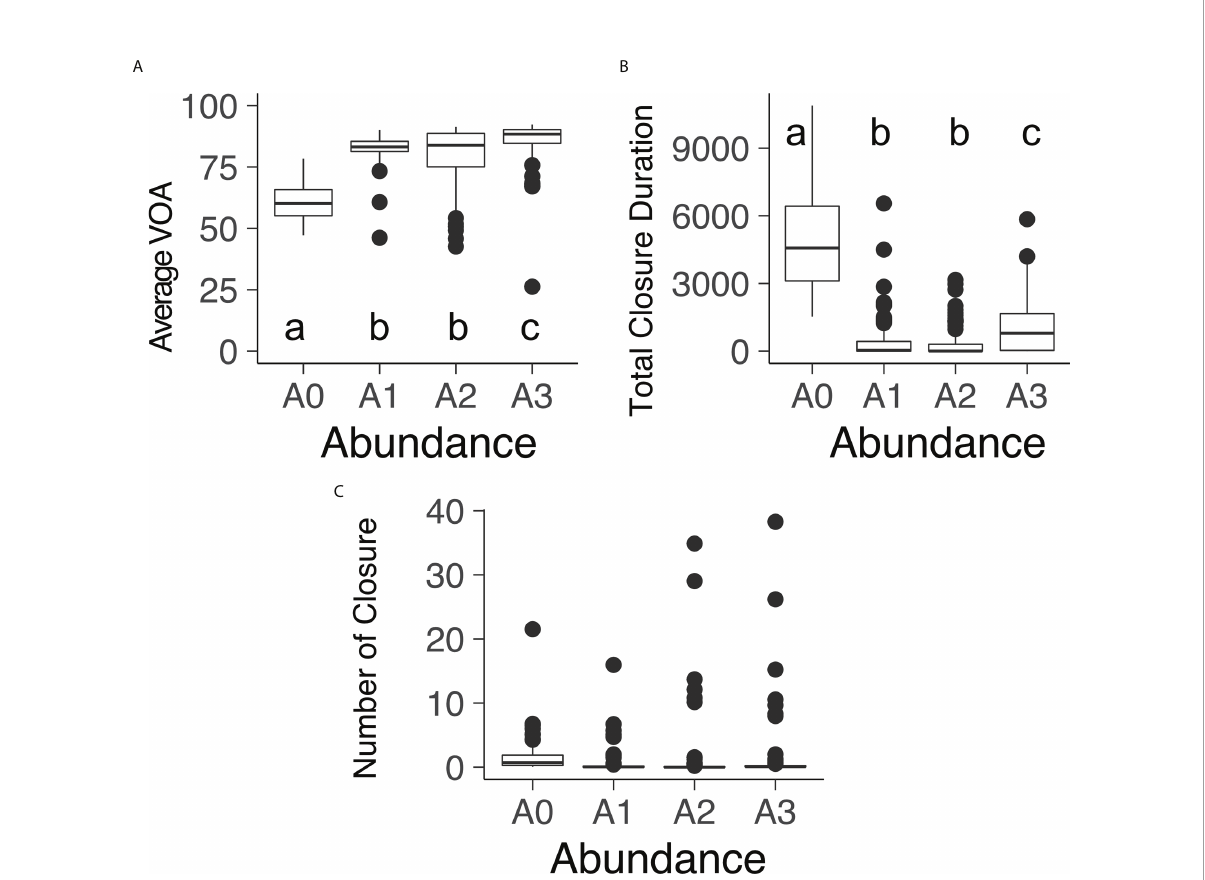
FIGURE 6 Boxplot of the (A) Average VOA, (B) total closure duration and (C) number of closures in function of the A. catenella abundance during the tested period of the time window of the fi g 5b. A0: 0 cell L -1 , A1: 560 cell L -1 (SE = 23.38), A2: 1190 cell L -1 (SE = 39.87), A3: 1680 cell L -1 (SE =